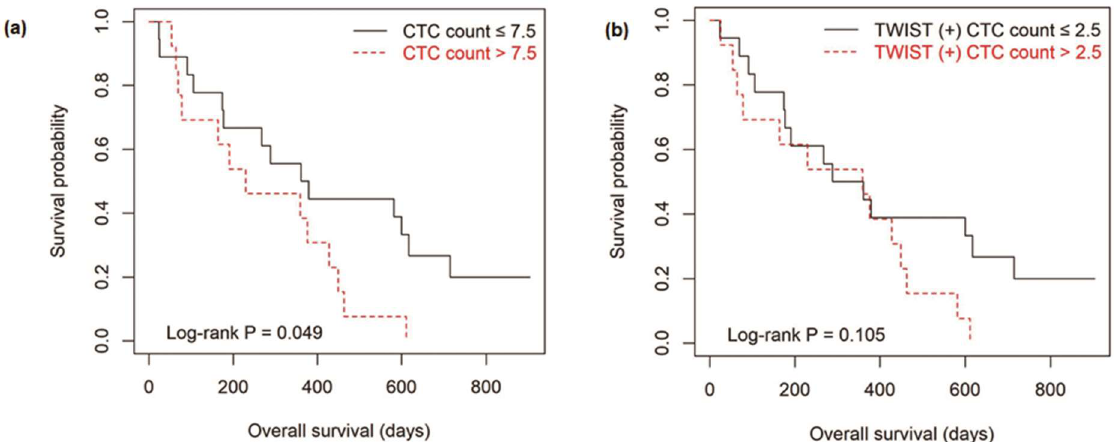
Figure 4. ( a ) Overall survival curves of 18 patients with ≤7.5 circulating tumor cells (CTCs) and 13 patients with >7.5 CTCs/7.5 mL of whole blood. ( b ) Overall survival curves of 18 patients with ≤2.5 TWIST (+) CTCs and 13 patients with >2.5 TWIST (+) CTCs/7.5 mL of whole blood.